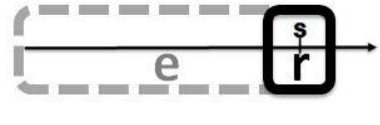
Figure 1a. Result of a single action